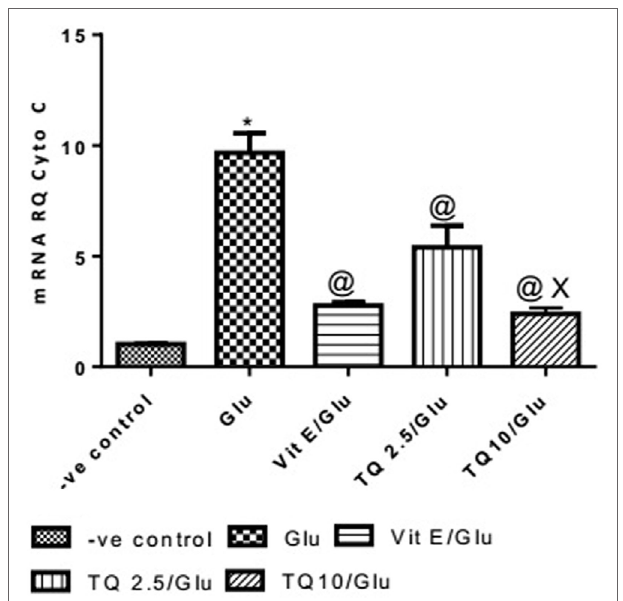
FigUre 1 | Effect of Glu, Vit E/Glu, TQ2.5/Glu, and TQ10/Glu on spatial memory in the Y-maze test. Glu was injected i.p. as a single dose for 7 days. TQ and Vit E were injected as a single dose for 7 days. Each value represents the mean value of 12 rats ± SEM. Statistics were carried out by one-way ANOVA followed by Tukey’s multiple comparison tests, by graph pad prism 5. *Statistically significant from − ve control group ( p < 0.05); @ statistically significant from Glu group ( p < 0.05); # statistically significant from Vit E/Glu group ( p < 0.05); X statistically significant from TQ 2.5/Glu group ( p < 0.05).